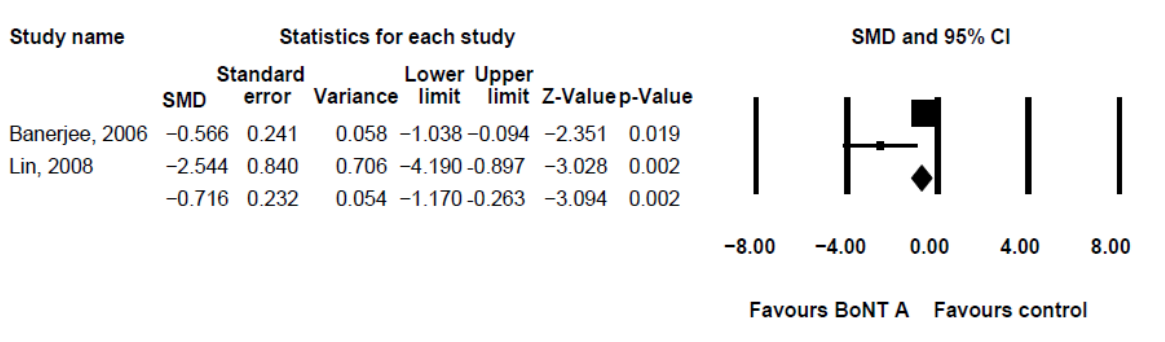
Figure 2. Meta-analysis of drooling quotient of botulinum toxin to salivary gland for the treatment of drooling in children with cerebral palsy. SMD, standard difference in means; CI, confidence interval.